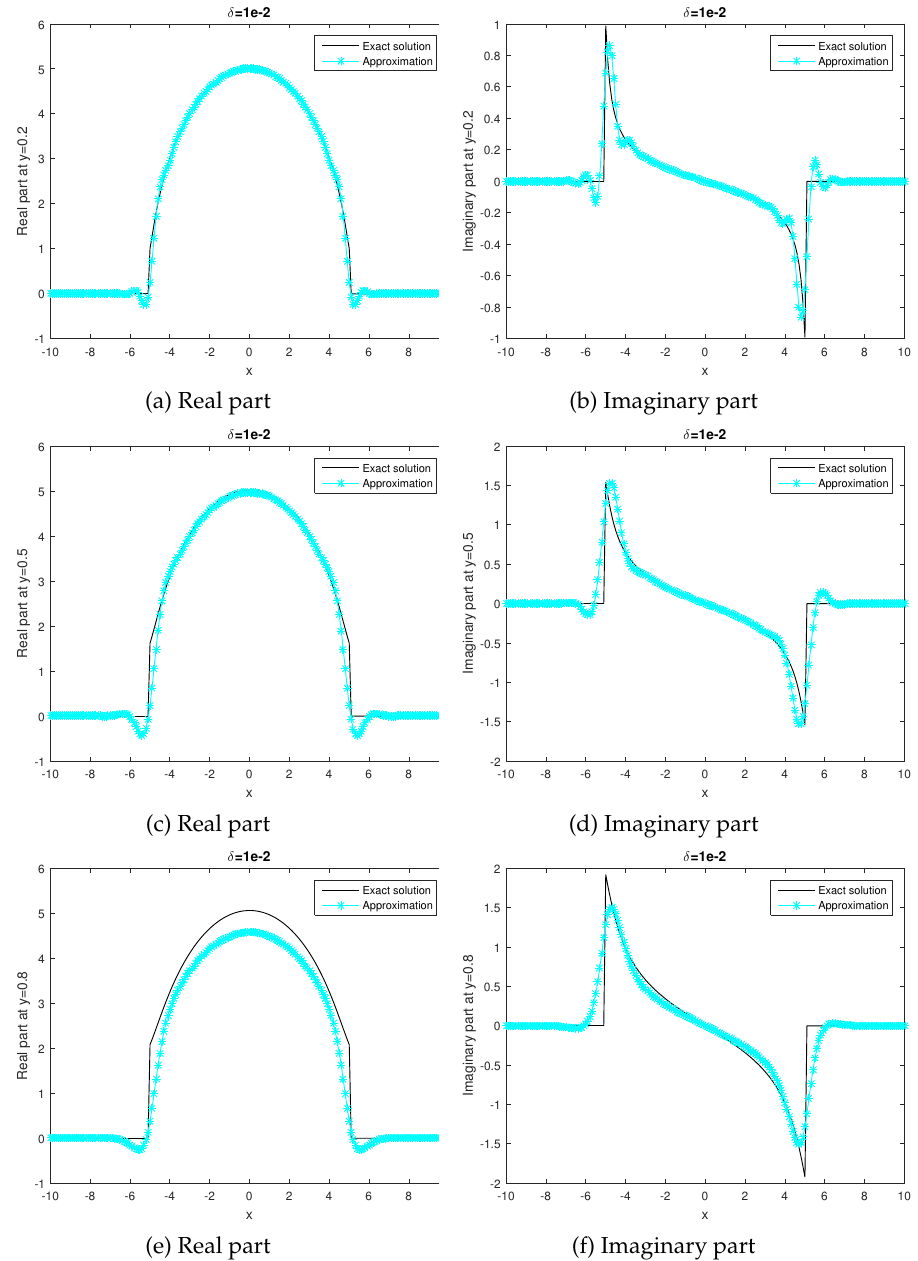
Figure 2. Example 4.2. Numerical results under the posteriori fractional Tikhonov method. Figure 2. Example 2. Numerical results under the posteriori fractional Tikhonov method. ( a , b ) are (a) and (b) are real part and imaginary part at y = 0.2, respectively, where µ = 1 e the real part and imaginary part at y = 0.2, respectively, where µ = 1 (c) and (d) are real part and imaginary part at y = 0.5, respectively, where µ = 0.01; and imaginary part at y = 0.5, respectively, where µ = 0.01; ( e , f ) are the real part and imaginary part (e) and (f) are real part and imaginary part at y = 0.8, respectively, where µ = 0.1. at y = 0.8, respectively, where µ =